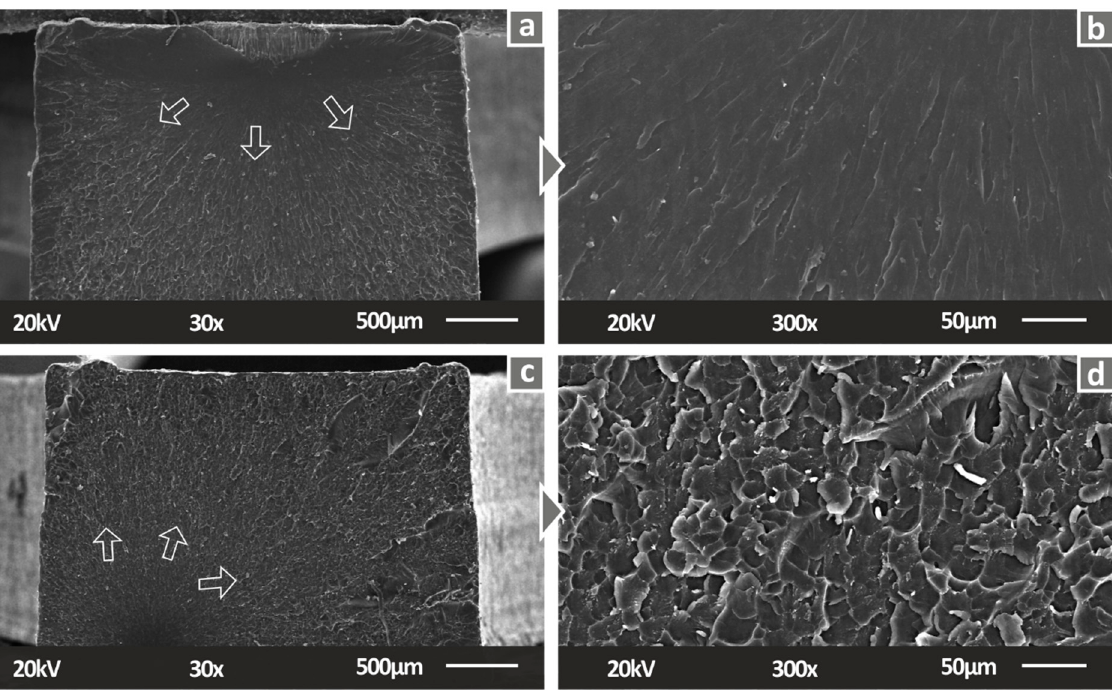
Figure 6. Fracture surface of tensile specimens in 30× magnification for ( a ) Pure SC, ( c ) SC Cu 2 O 0.5 wt.%, ( e ) SC Cu 2 O 1.0 wt.%, ( g ) SC Cu 2 O 2.0 wt.%, same surfaces in 300× magnification for ( b ) Pure SC, ( d ) SC Cu 2 O 0.5 wt.%, ( f ) SC Cu 2 O 1.0 wt.%, ( h ) SC Cu 2 O 2.0 wt.%.